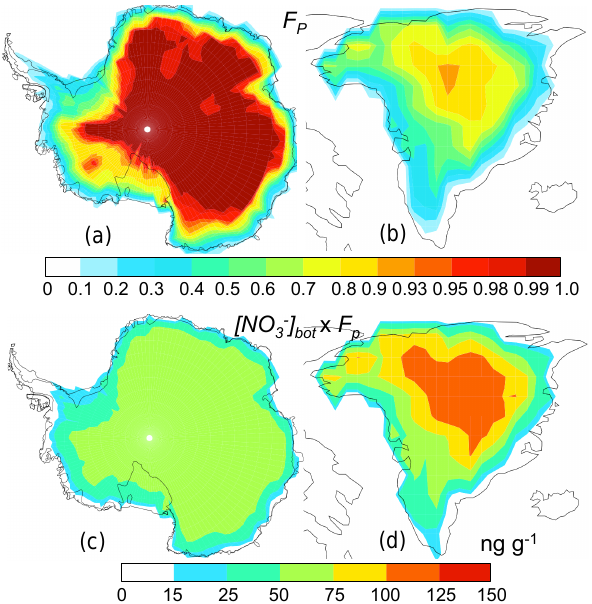
Figure 4. (a, b) Ratio of annual dry-deposited NO − deposited NO − , F P . (c, d) Annual sub-surface snow NO − 3 ] × F p ) used in the trations ([NO − bot 3